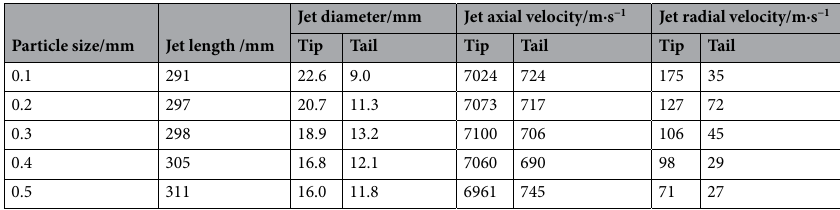
Table 4. Calculation results of the different particle sizes at 60